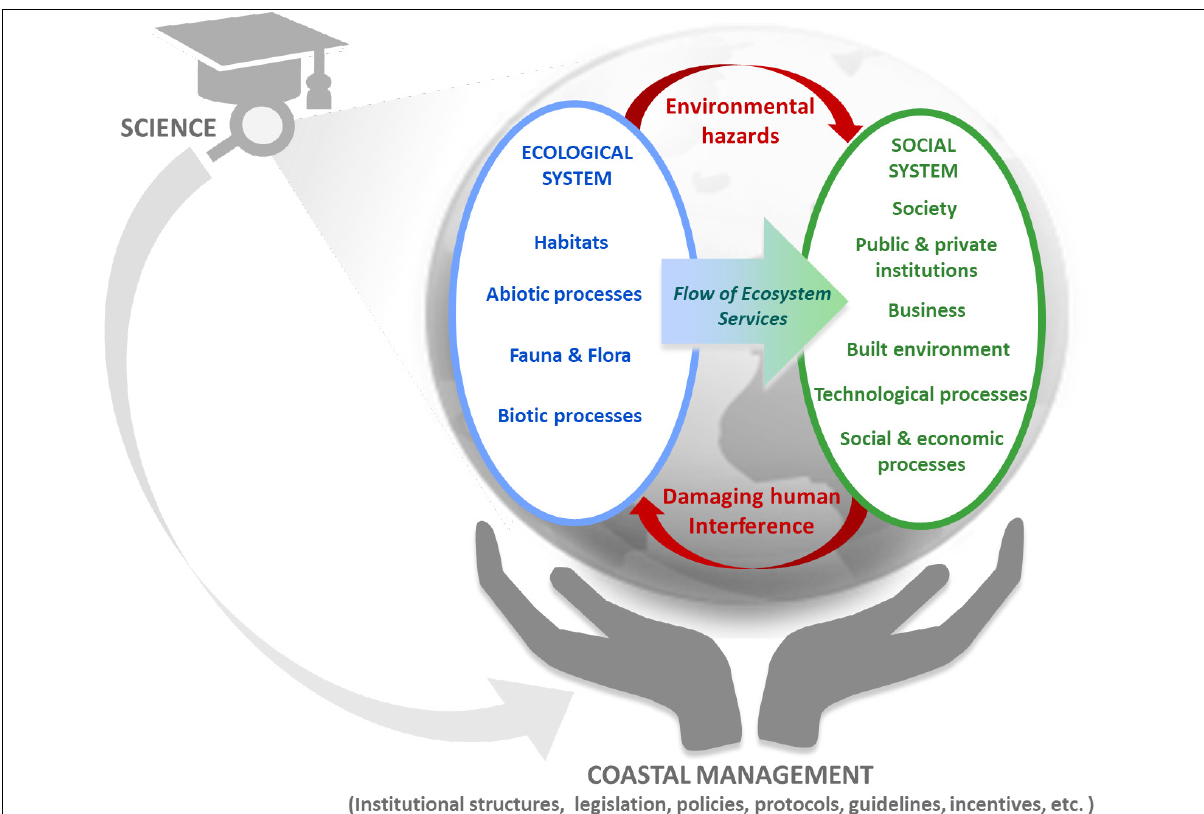
Figure 1: Conceptualisation of a coastal social-ecological system, as well as the role of coastal management and